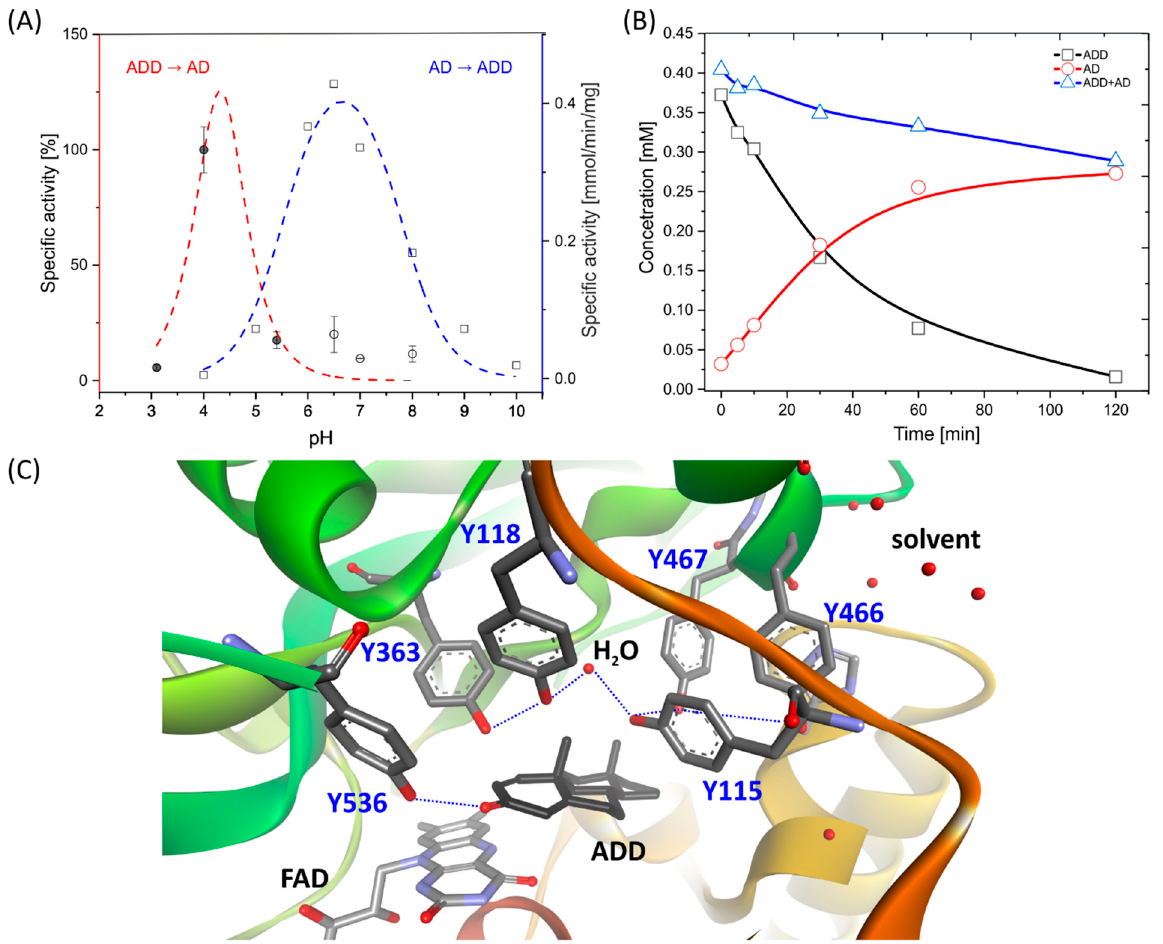
Figure 2. 1,2-Hydrogenation catalyzed by AcmB from S. denitrificans Chol-1 with ADD as a substrate and BV + as an electron donor in the presence of dithionite. ( A ) The pH optimum of the reaction obtained through a spectrophotometric assay, red line and grey circles—activities measured in 50 mM of citrate buffer, white circles—activities measured in 50 mM of phosphate buffer compared to the pH optimum for 1,2-dehydrogenation catalyzed by AcmB with DCPIP as an electron acceptor ([11], changed), blue line, white squares. ( B ) The progress of 1,2-hydrogenation at pH 6.5 in a fed-batch reactor monitored by HPLC: squares ADD, circles AD, triangles sum of ADD and AD. ( C ) Active site of AcmB with ADD bound at the active site with a chain of tyrosines forming catalytic machinery and the proton relay system.